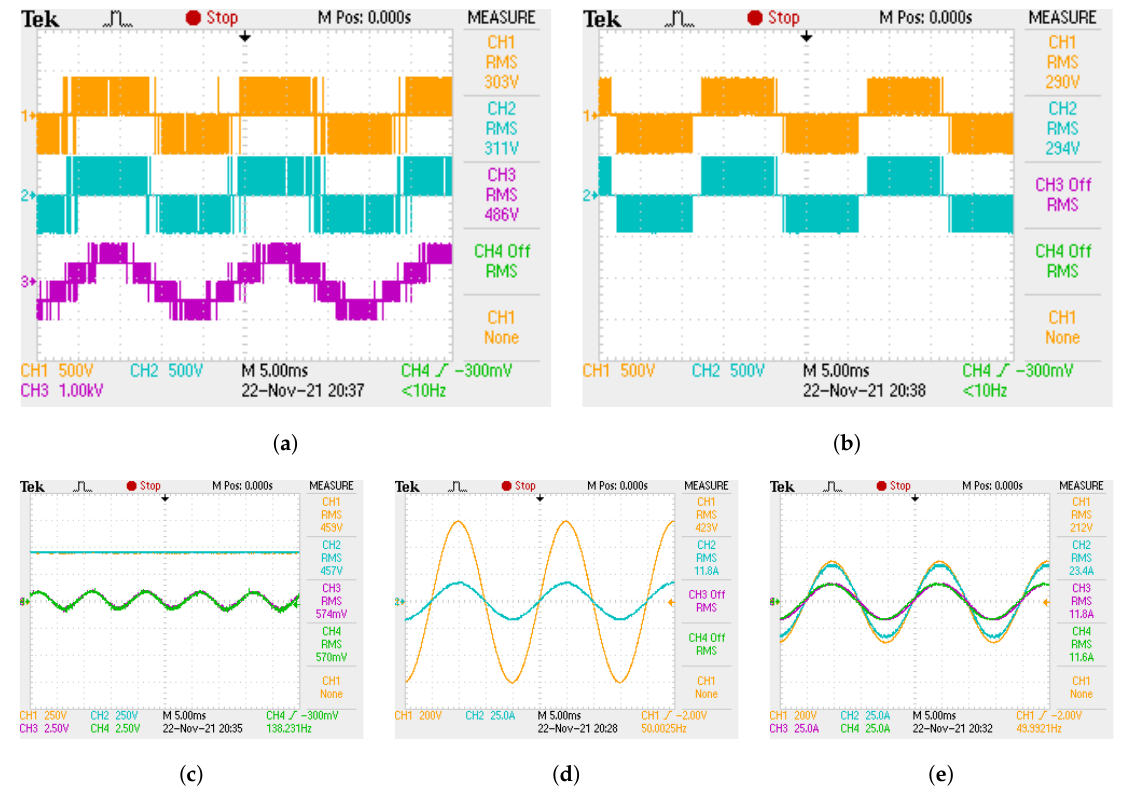
Figure 22. 2-modules ISOP configuration experimental results: ( a ) Primary side switching voltages, ( b ) Secondary side switching voltages, ( c ) DC-links voltages, ( d ) Primary side grid voltage and current, ( e ) Secondary side grid voltage and